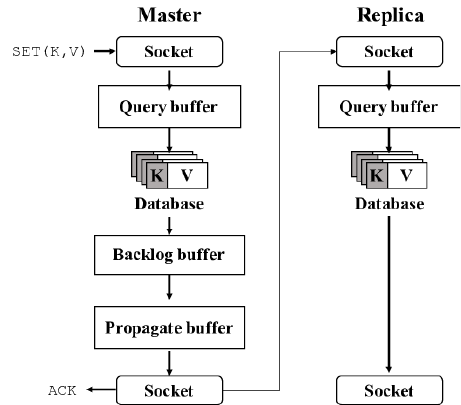
Figure 4. Write path of master and replica in